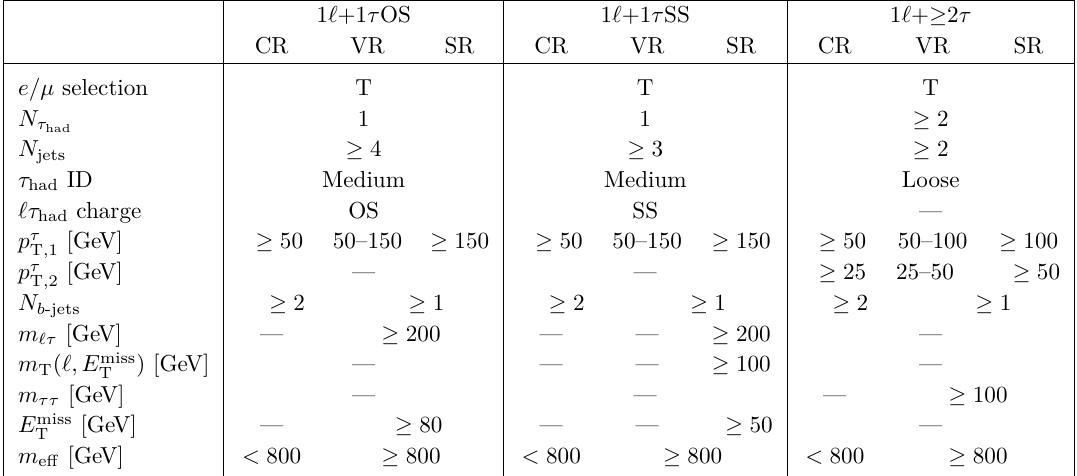
and p τ , respectively. T , 1 T , 2